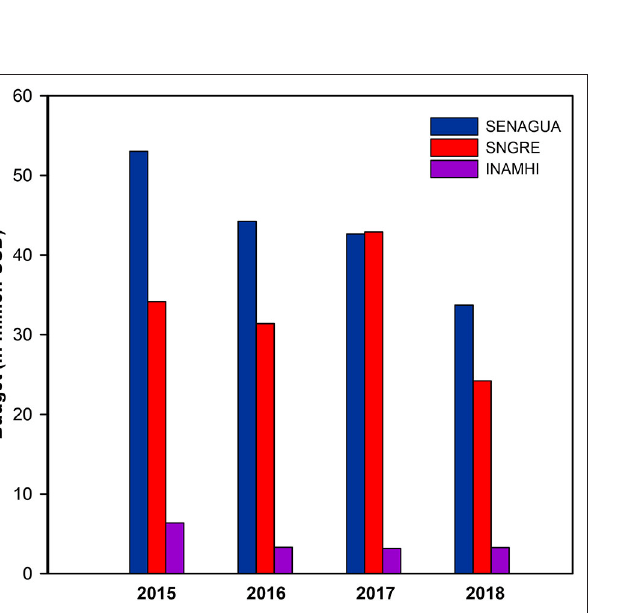
FIGURE 3 | Budgets assigned by the state to institutions related to FRM in Ecuador. Data is available through the official annual accountability reports in the corresponding sources: SENAGUA (https://www.agua.gob.ec), SNGRE (https://www.gestionderiesgos.gob.ec), and INAMHI (https://www.